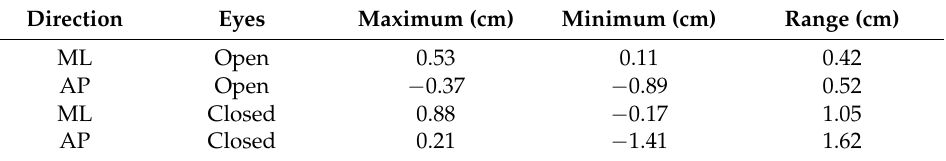
Table 2. Comparison of stabilogram parameters for quiet standing with and without visual feedback.